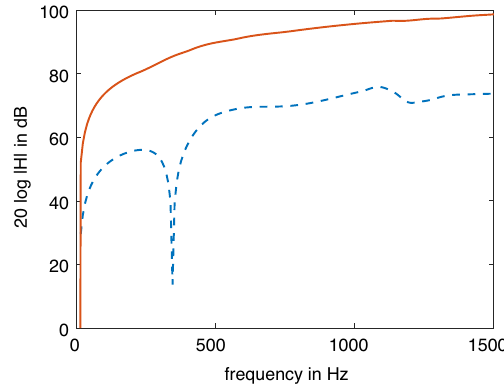
Figure 3. Example for transfer functions for the radiation of one patch on the plate to a position directly above the plate (solid line) and on the half sphere (dashed line).